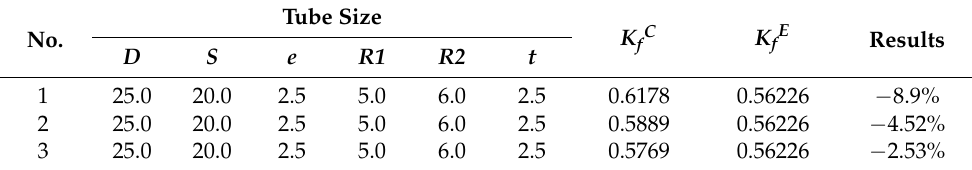
Thus, the error was less than 10%, which is acceptable in engineering. Table 4. Experimental verification of K fC for the conically corrugated